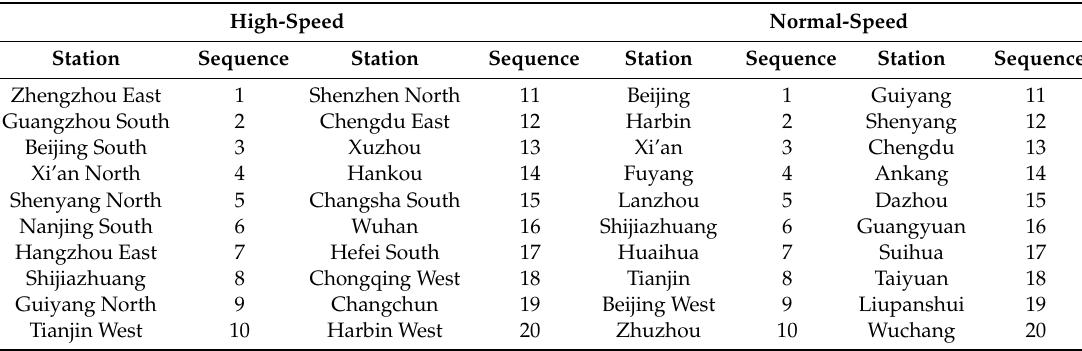
Table 3. Top 20 railway stations with largest